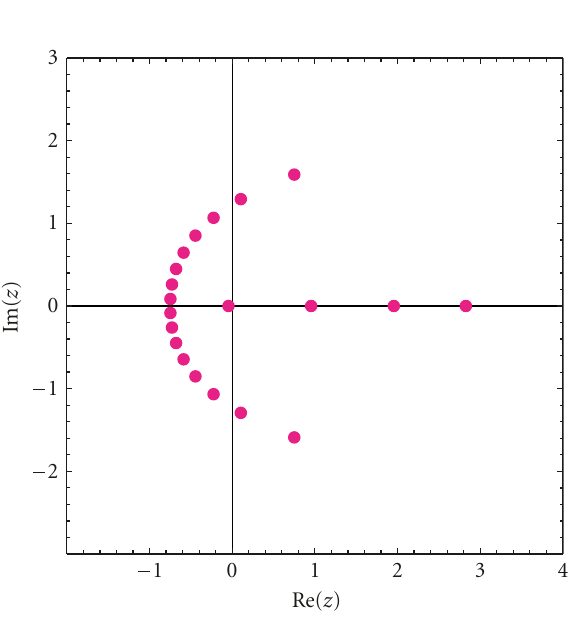
Figure 4.2 . Zeros of E 20, q , w ( x